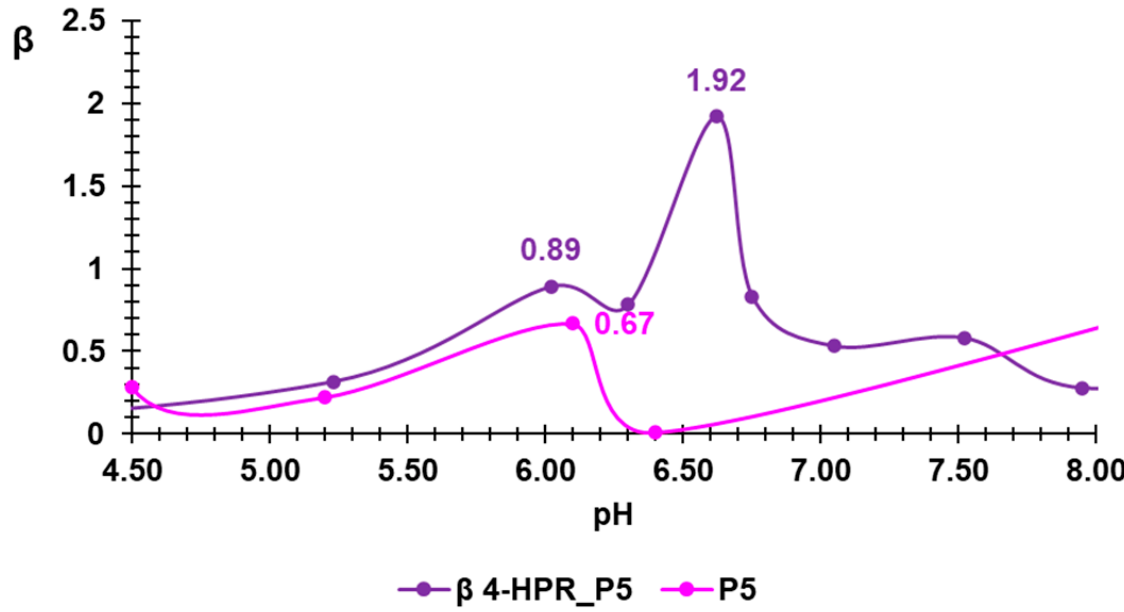
Figure 4. Buffer capacity curves of P5 and 4-HPR-P5 NPs.